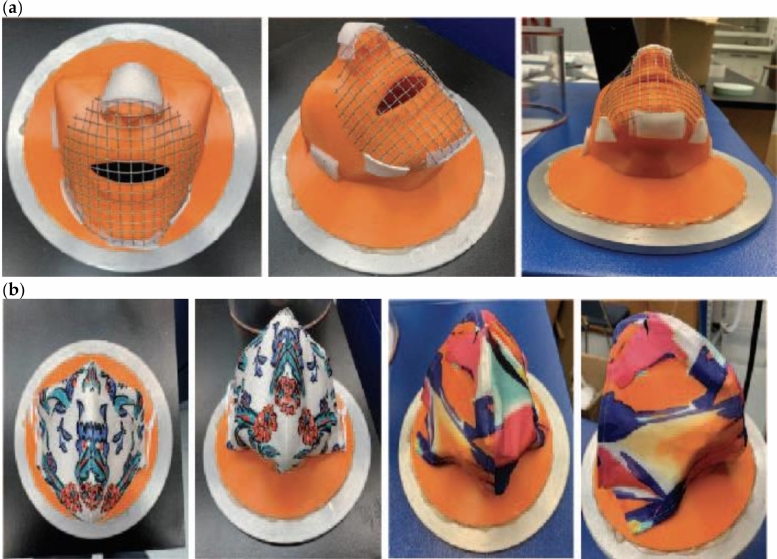
Figure 1. ( a ) 3D mask model with wire and double-sided tape adaptation to secure mask into place during testing. ( b ) 3D mask with mask samples showing mask placement during